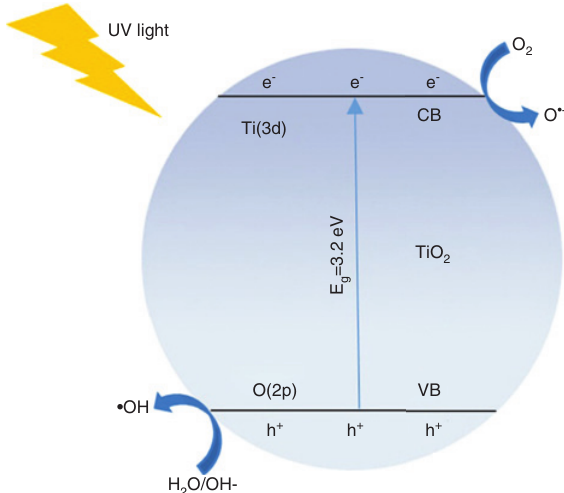
Figure 18: Schematic diagram for photocatalytic degradation of pollutants under UV